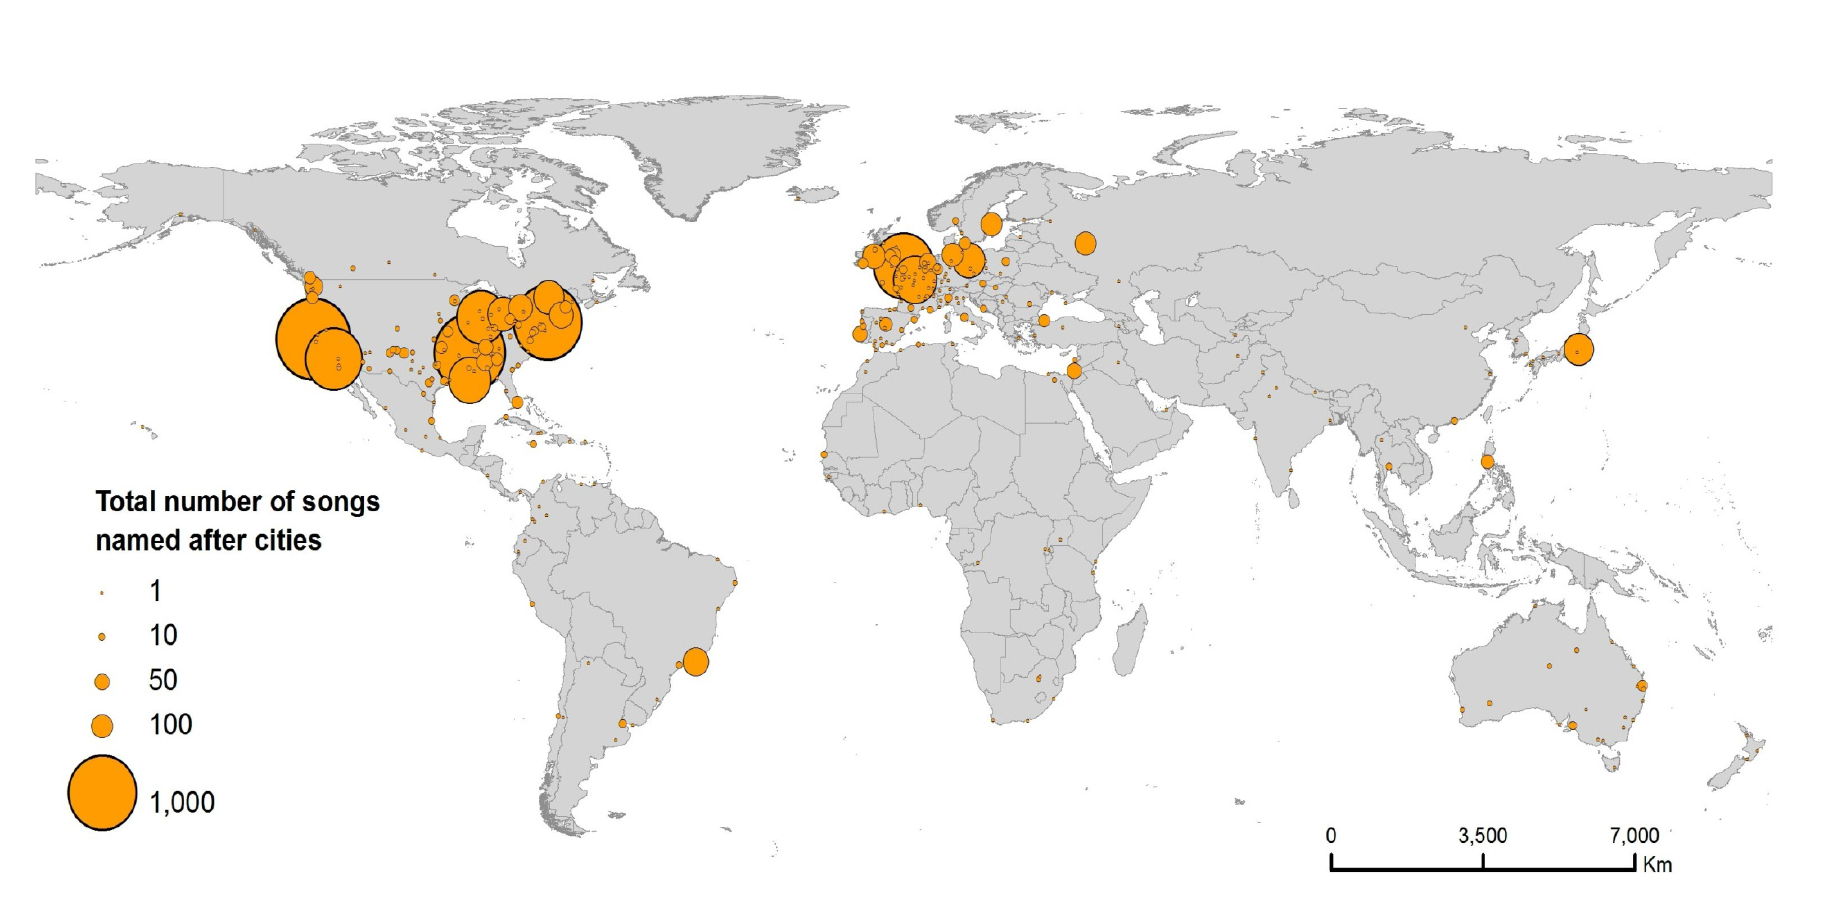
Figure 2: Songs featuring cities and towns in their